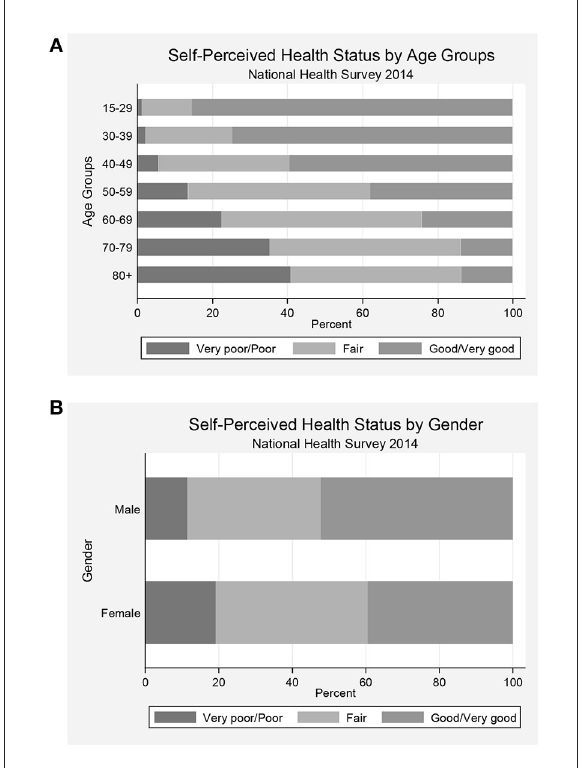
FIGURE1 Prevalence of health perception status categories in Portugal according to age group (A) and sex (B)